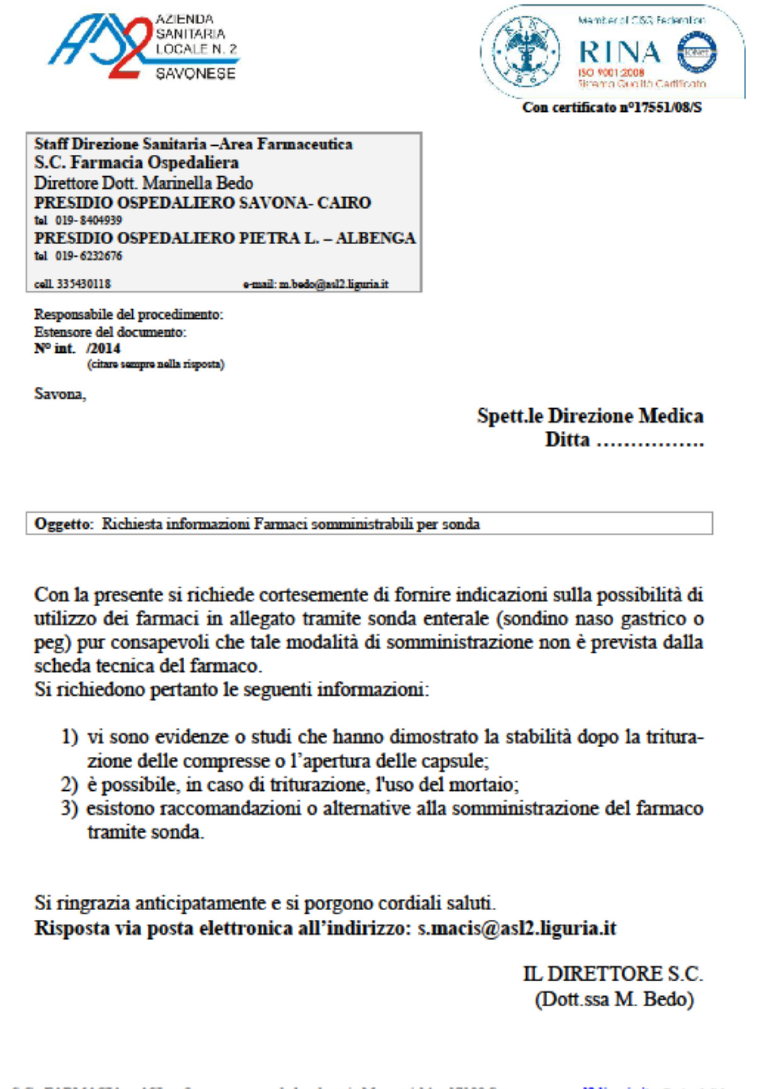
Figure 1. Letter addressed to the pharmaceutical companies whose products appear on the hospital formulary.